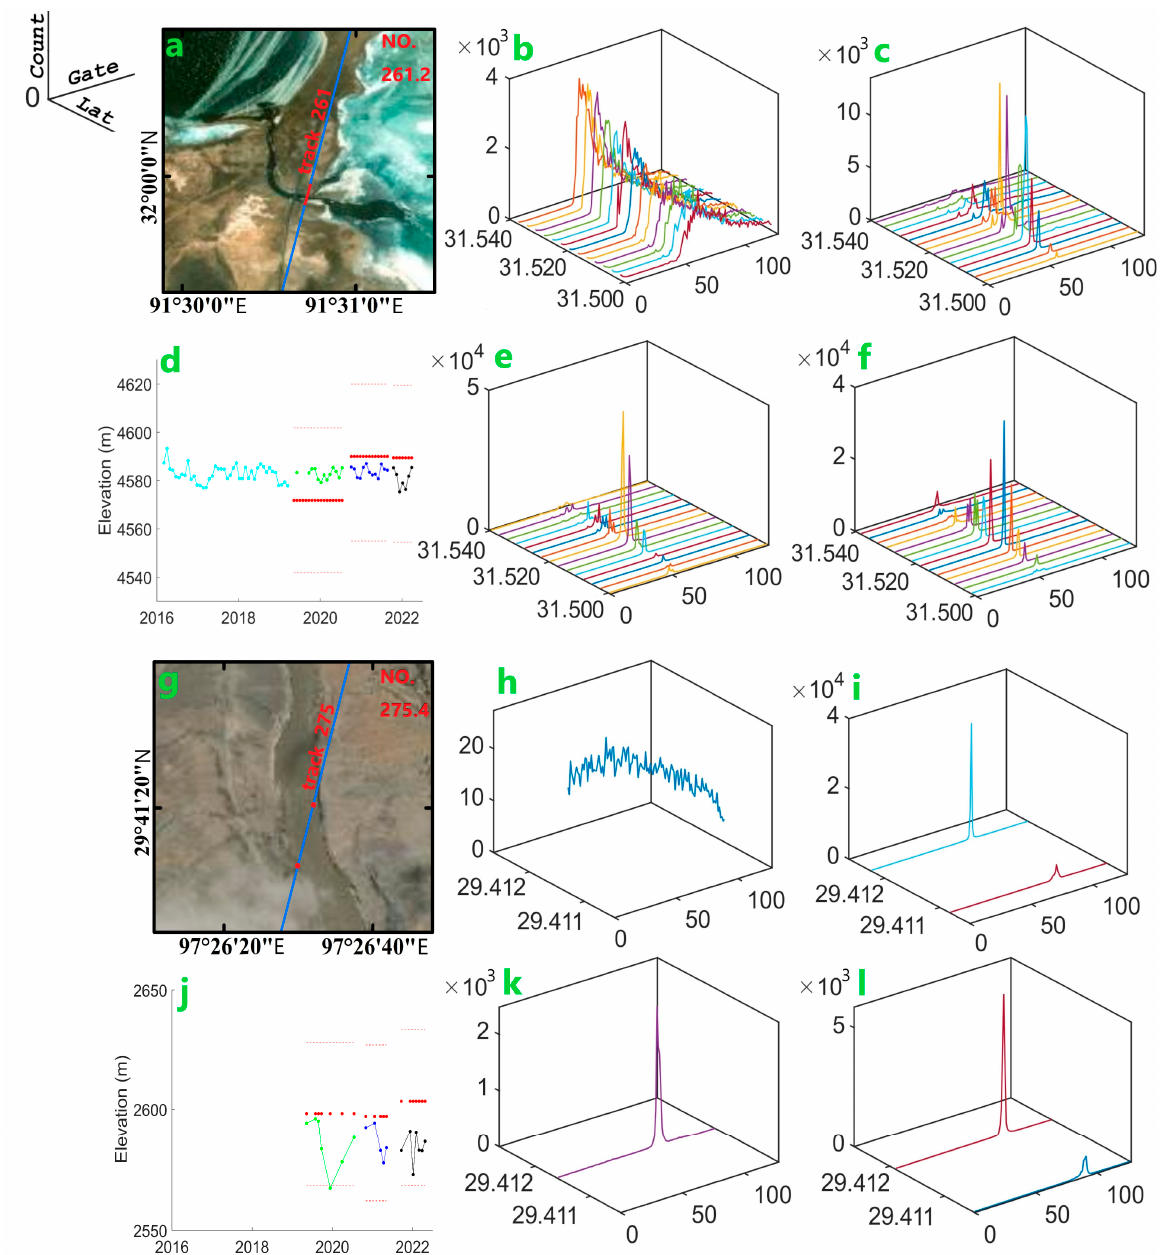
Figure 5. Two typical cases of virtual stations (VSs) in ( a – f ) high elevation and wide river (HW) and ( g – l ) high elevation and narrow river (HN). The satellite image shows the locations of the VSs, with the orbit of Sentinel ‐ 3A (S3A) indicated by the blue line. The orbit numbers are shown in red next to the orbit, and the red dots on the orbit indicate the location of the satellite emitting detection waves at the corresponding VSs. The VSs number is displayed in red font in the upper right corner of the image. The red dots in the scatter chart ( d , j ) represent the elevation of OLTC while the pink dots represent the size of the range window. The four waveforms refer to the closed ‐ loop ( b , h ) and OLTC V5.0 ( c , i ), OLTC V6.0 ( e , k ), and OLTC V6.1 ( f , l ). ( d , j ) show the time series of the WSE for the specific VS, where azure, green, blue, and black refer to closed ‐ loop, OLTC V5.0, OLTC V6.0, and OLTC V6.1.